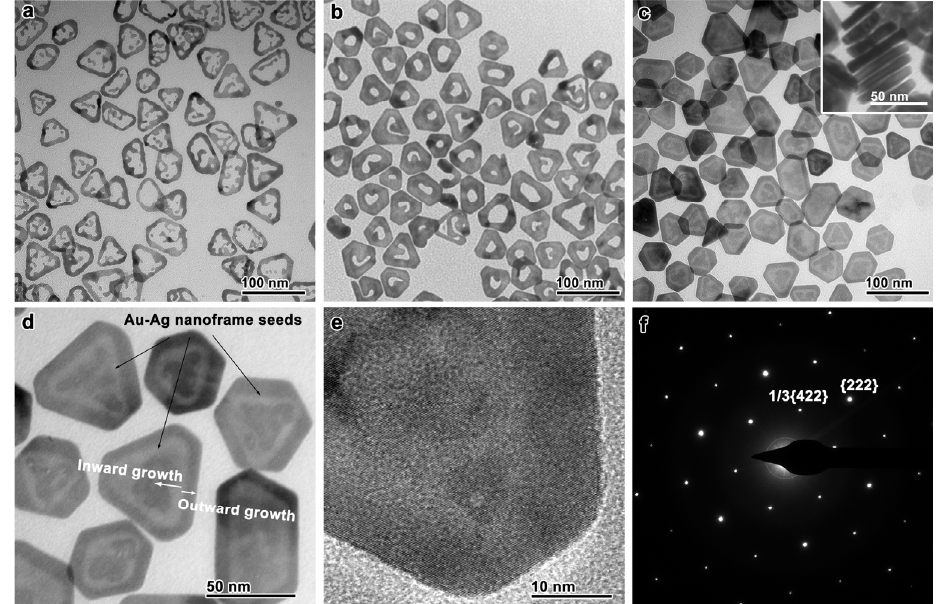
Figure 1. Monitoring the synthesis of Au nanoplates by TEM imaging. ( a ) Au–Ag-alloy nanoframes as the seeds for the seed-mediated synthesis. ( b ) An intermediate of the crystal growth. ( c ) The final product of the Au nanoplates. Inset: Au nanoplates standing vertically. ( d ) An enlarged TEM image, showing the low-contrast “watermark” corresponding to the Au–Ag-alloy-nanoframe seed and the schematic directions of the seed-mediated growth. ( e ) HRTEM image of the Au nanoplates. ( f ) The electron-diffraction pattern of the Au nanoplates.